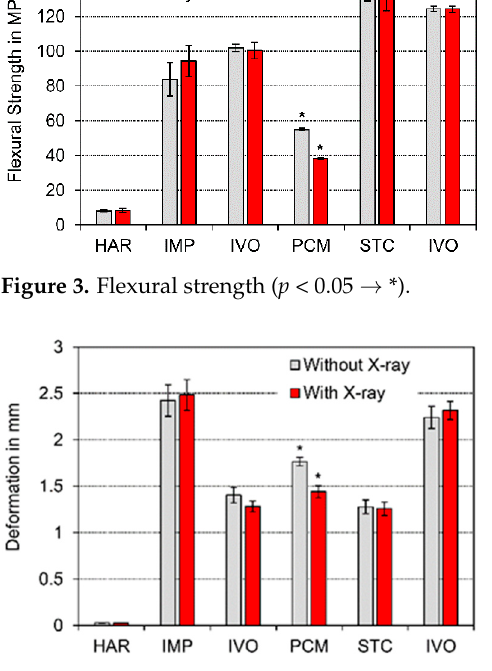
Figure 4. Deformation at the maximum load ( p < 0.05 → *).